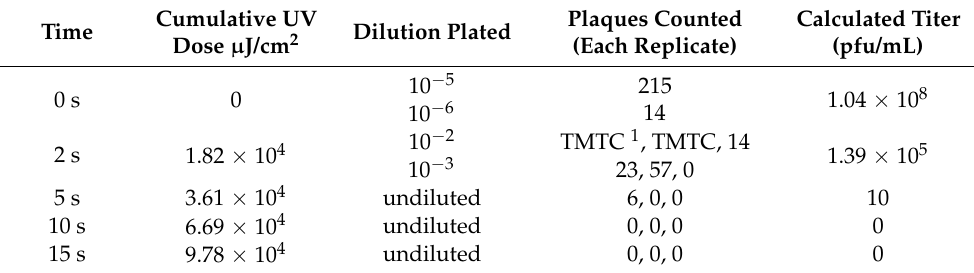
Table 2. UV-C inactivation of 15 mL in open-top bacterial Dish.